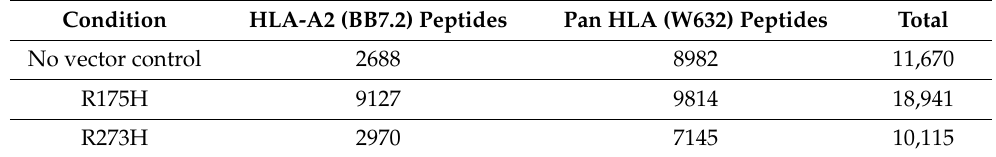
Table 1. Number of HLA class I peptides (8–15 mers) identified across transfected SaOS cell